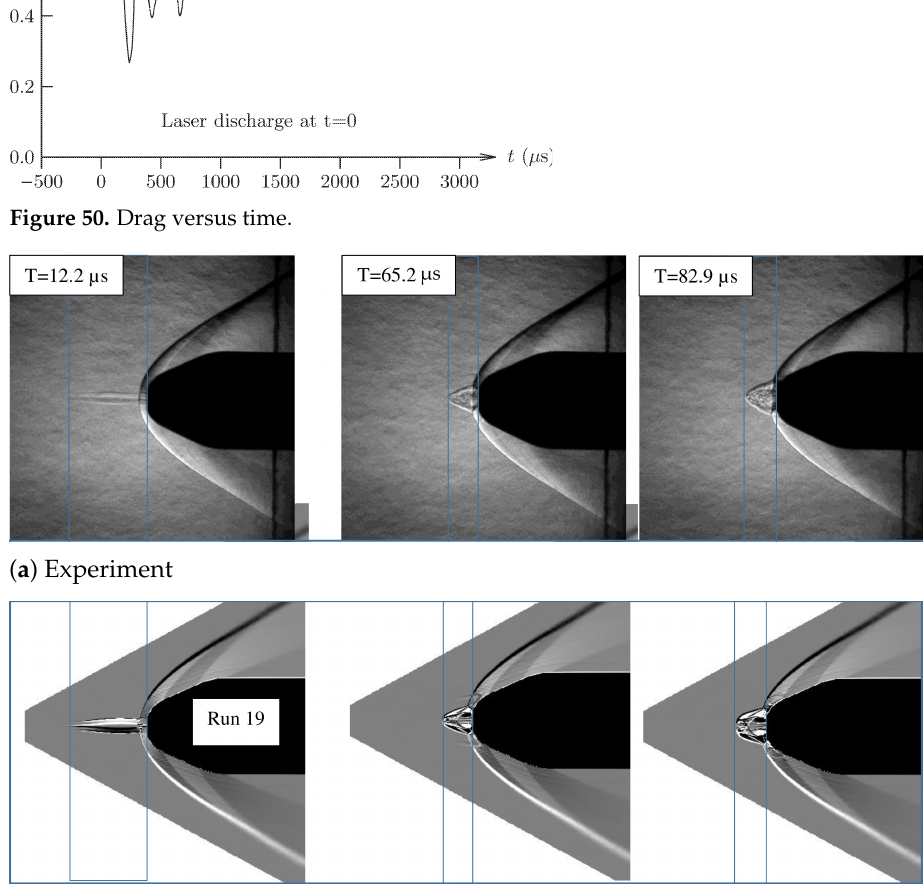
Figure 51. Comparison of experiment and simulation. Reprint from [96] with permission from